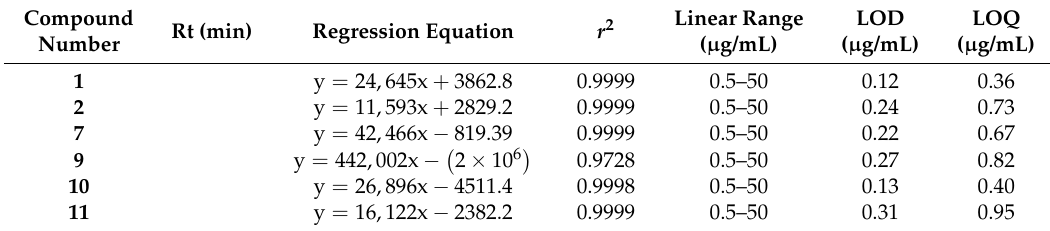
Table 6. Linear relation between peak area and concentration ( n =